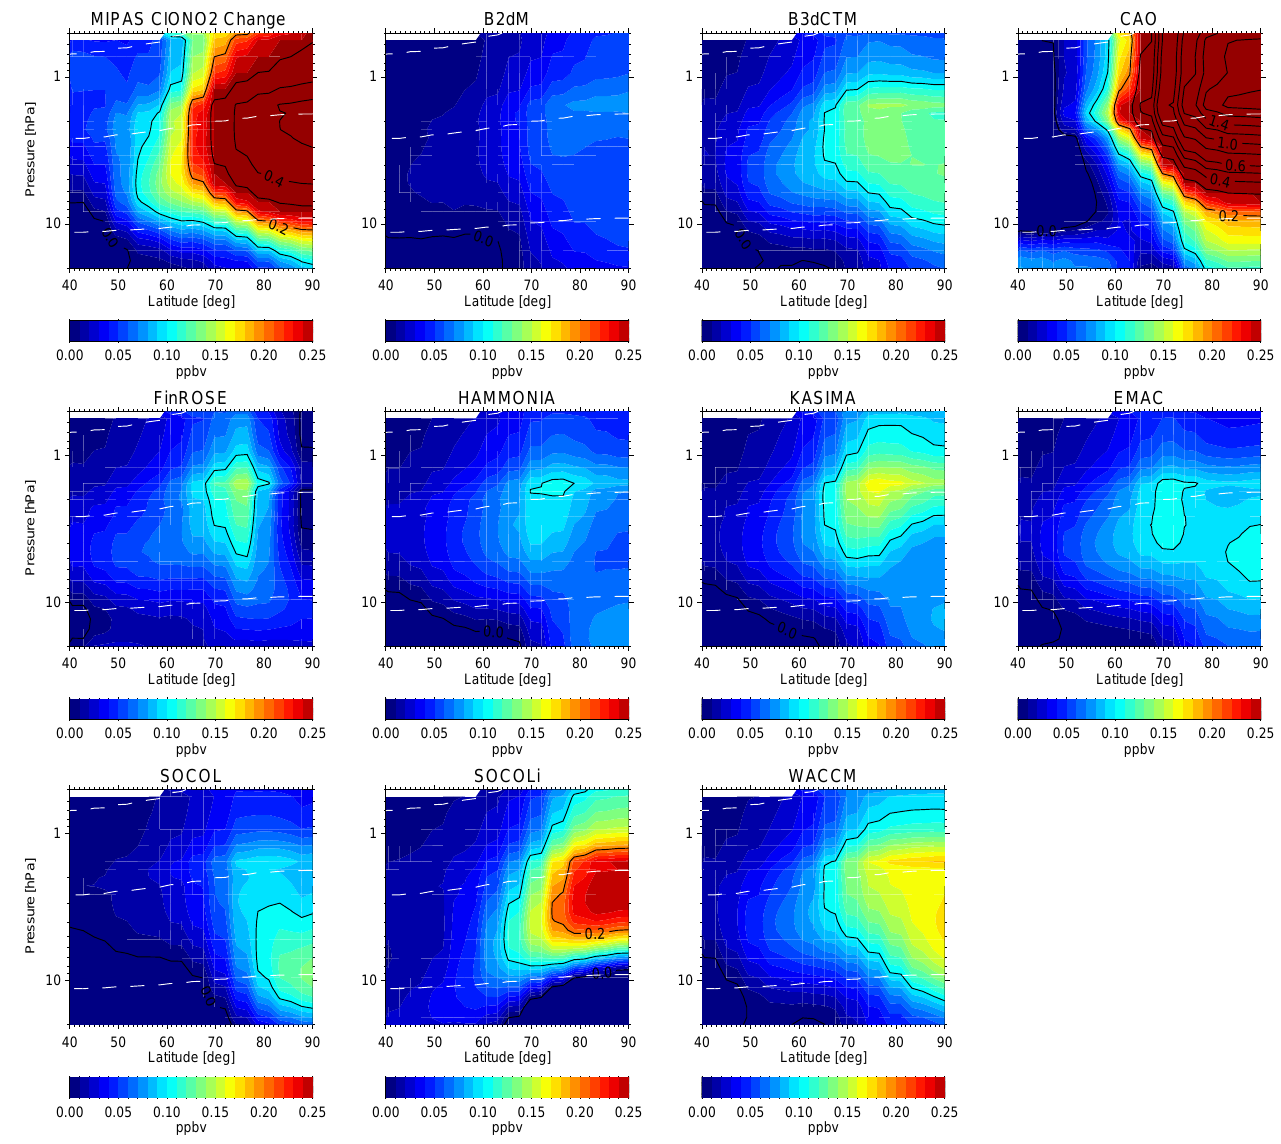
Fig. 37. Zonal mean ClONO 2 changes after the main proton forcing (1–5 November) with respect to 26–27 October in MIPAS observations and model simulations. Solid contour lines reflect 0.1ppbv steps up to 0.6ppbv and 0.2ppbv steps above. Fig. 37. Zonal mean ClONO changes after the main proton forcing (1–5 November) with respect to 26–27 October in MIPAS observations 2 and model simulations. Solid contour lines reflect 0.1 ppbv steps up to 0.6 ppbv and 0.2 ppbv steps above. After a sudden decrease on 13 November, ClONO 2 abun- Figure 37 shows the corresponding zonal mean distribu- dances increased again on 19 November, reaching a sec- tion of the observed and modeled ClONO 2 enhancements ond, weaker maximum around 22 November. The modeled averaged over 1–5 November. From the observations, it is ClONO 2 increases are generally smaller (except CAO, see clear that ClONO 2 is principally formed in the polar night re- discussion above) and show a different temporal evolution. gion where high NO 2 abundances are available and no photo- The ClONO 2 underestimation in the simulations, particularly chemical losses occur. Most of the model simulations, except during the first enhancement starting on 1 November, is re- CAO, SOCOLi and WACCM, show negligible enhancements lated to the reduced ClO availability compared to the obser- there. Instead, ClONO 2 formation occurs around 70 ◦ N, vations. As an exception, CAO yields a quasi-instantaneous were daytime losses are still small but ClO is available, how- ClONO 2 increase with the onset of the proton forcing which ever, with a considerably smaller magnitude than can be explained by the use of a family approach for NO y and ClO y in this model.